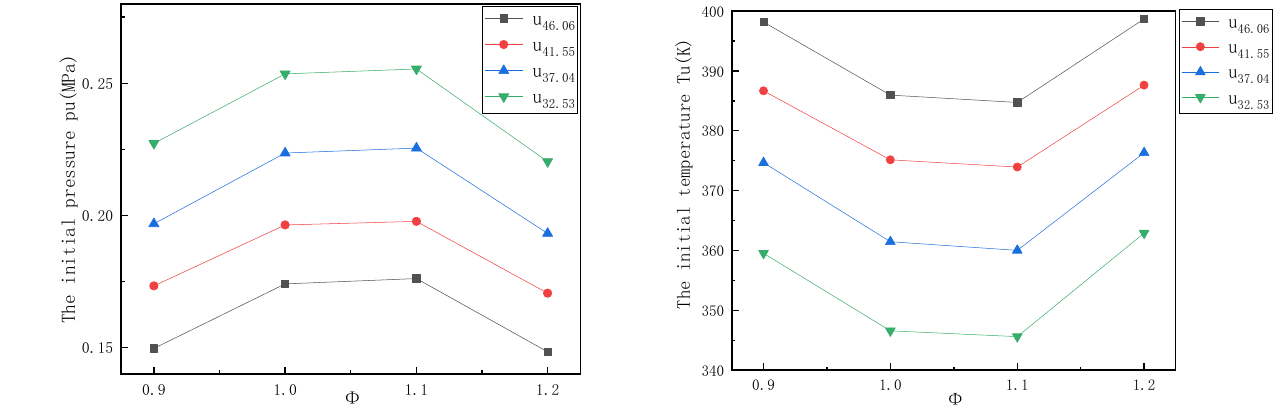
Figure 5. Equivalent variation of u L corresponding to the initial condition change with Φ.